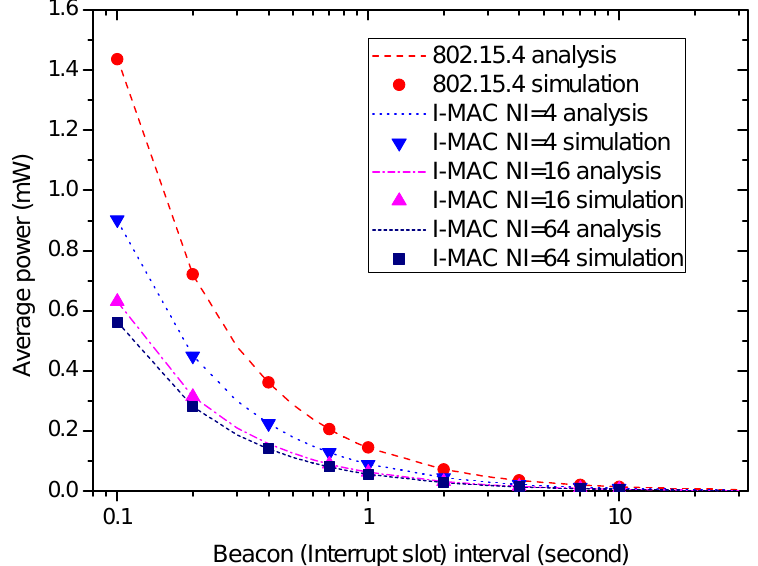
Figure 11. The effects of the beacon interval and interrupt interval on node average